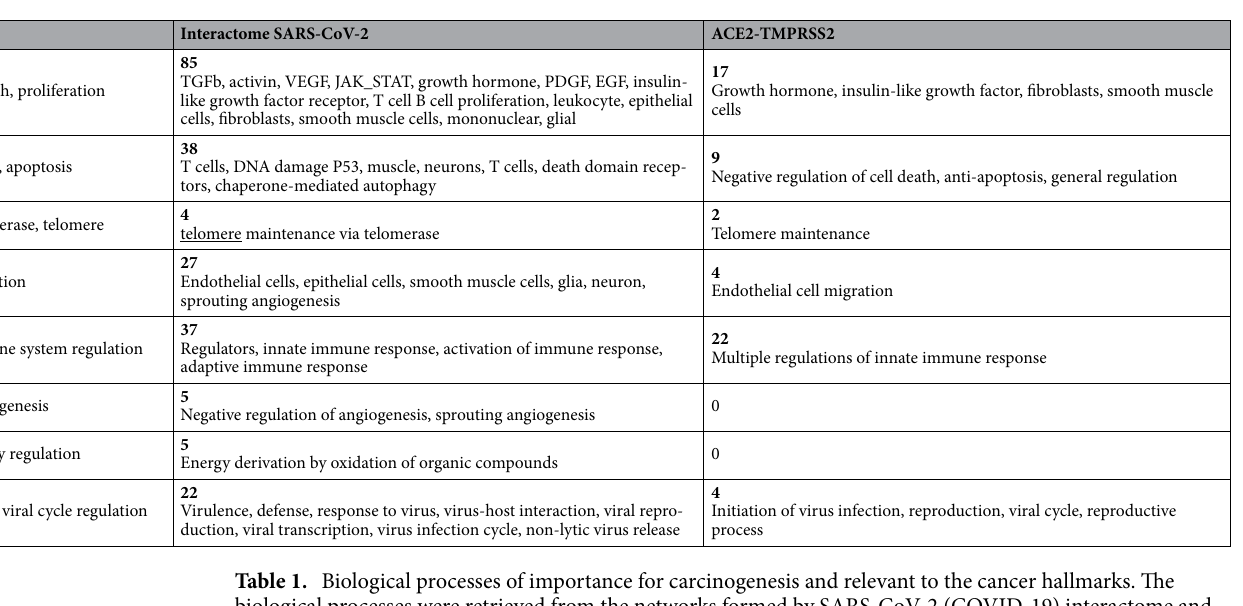
Table 1. Biological processes of importance for carcinogenesis and relevant to the cancer hallmarks. The biological processes were retrieved from the networks formed by SARS-CoV-2 (COVID-19) interactome and ACE2 + TMPRSS2. BiNGO tool was used to search for the processes in H. sapiens , with p < 0.05 for significance of retrieved data. Hypergeometric statistical test was used, with Benjamini and Hochberg false discovery rate correction. Numbers (in bold) and examples of retrieved biological processes are shown; cancer hallmarks searches that did not retrieve processes are not shown.